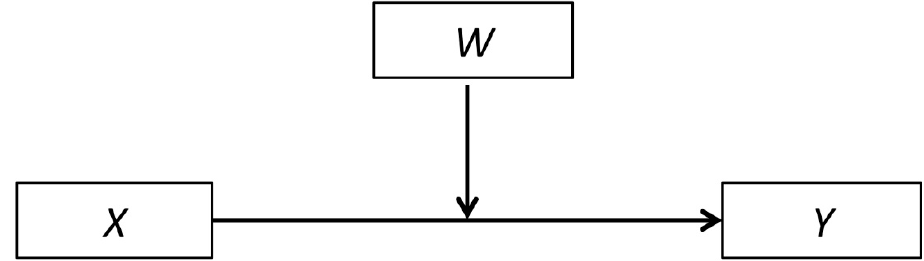
Figure 1. Moderation model where X represents an independent variable, Y the outcome variable, and W the moderating variable (figure based on [80]).